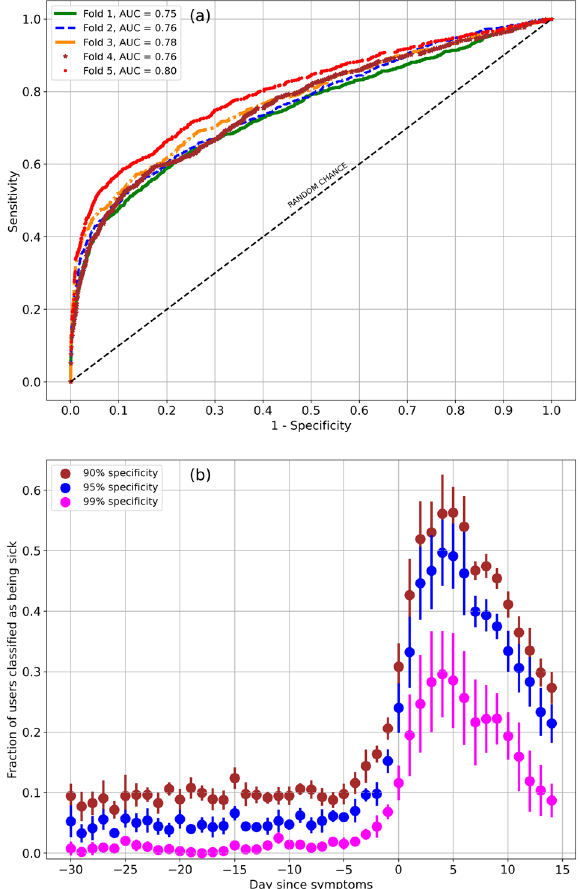
Fig. 3 Classi fi er performance. Predicting sickness given the physiological signs: a with fi ve-fold validation, the AUC is 0.77 ± 0.018. Data from day − 21 to day − 8 were treated as negative cases, while data from day + 1 to day + 7 were assumed positive. Data from day − 7 to day 0 were ignored. Day 0 was the day when symptoms were reported. The sensitivity is 0.259 ± 0.059 at 99% speci fi city, 0.437 ± 0.037 at 95% speci fi city, and 0.513 ± 0.034 at 90% speci fi city. b The fraction of users predicted positive on speci fi c days, from